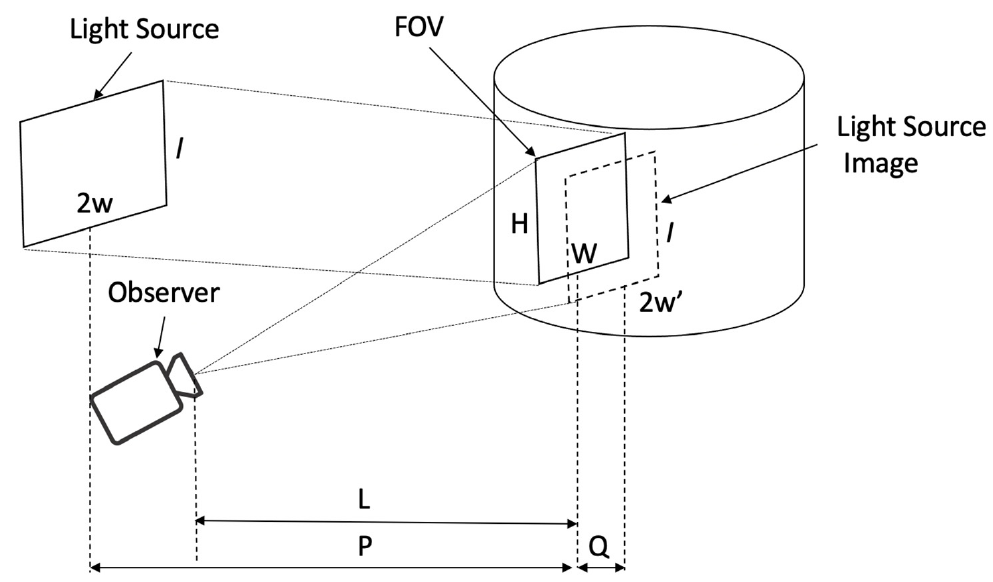
Figure 3. The geometry of specular reflection imaging. Distance P is critical, but Distance L does not impact the methodology (can be larger or smaller than P). Further, the observer (i.e., camera) is not aligned with the light source.